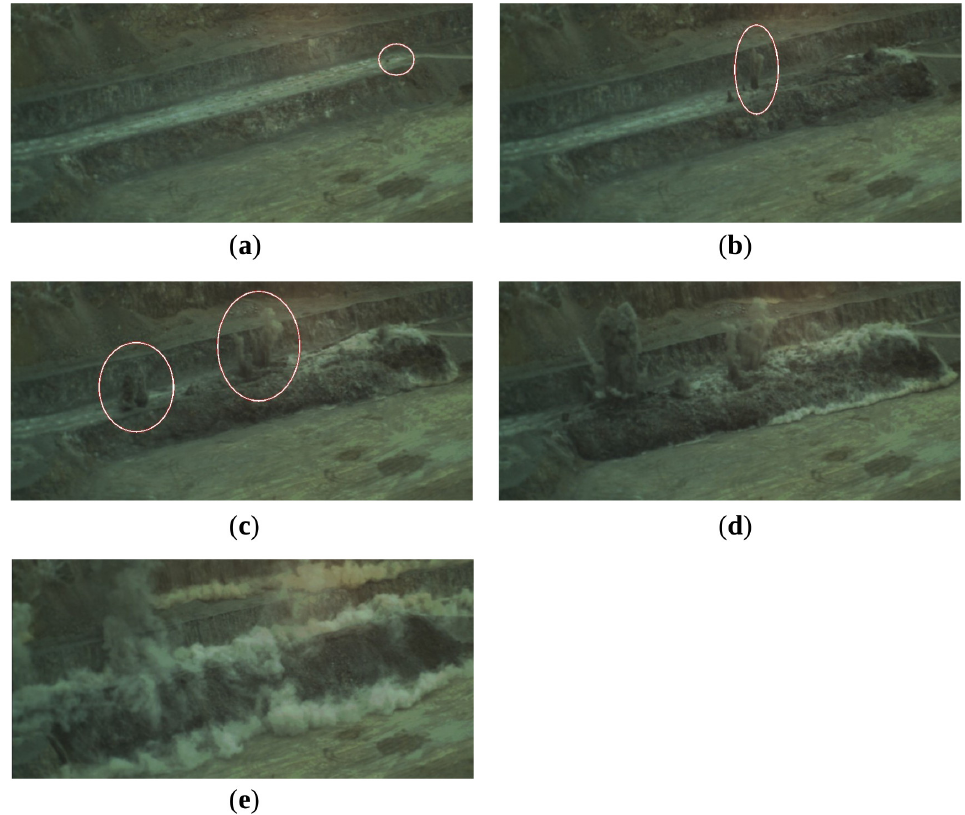
Figure 8. Frames of high-speed video footage from a blast at Mine D. ( a ) Initiation, ( b , c ) stemming ejection, ( d ) all holes blasted and ( e ) result of the